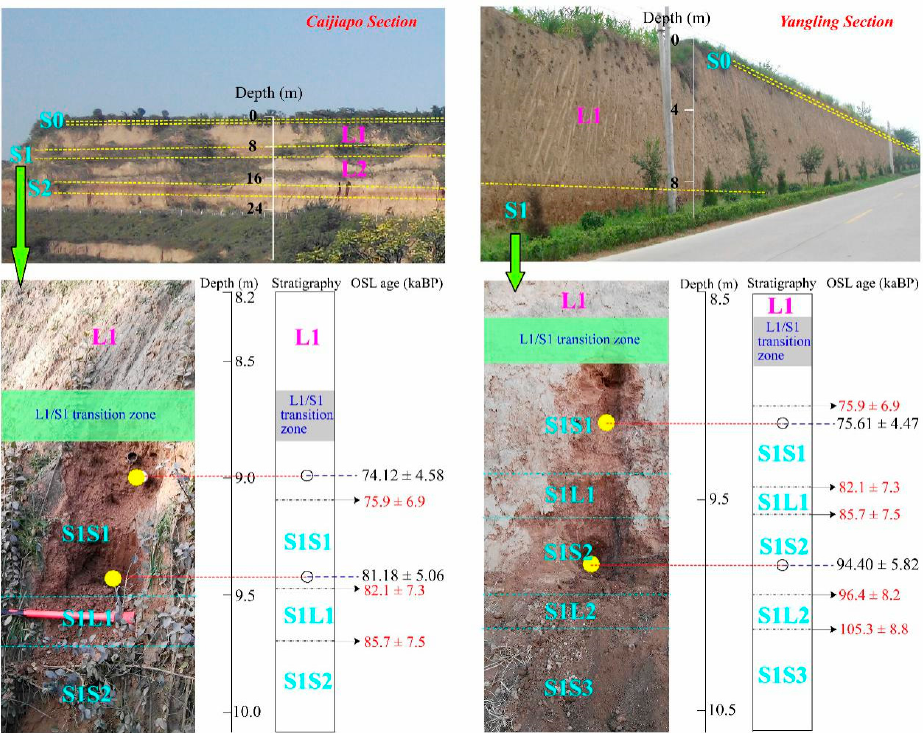
Figure 2. The loess-paleosol sequences at Caijiapo ( left ) and Yangling profiles ( right ). The Caijiapo section showed Holocene loess (S0), last glacial loess (L1), last interglacial paleosol (S1), penultimate glacial loess (L2), and the penultimate interglacial paleosol (S2). The Yangling section showed Holocene loess (S0), last glacial loess (L1), the last interglacial paleosol (S1). The first layer of the paleosols (S1) is divided into five sub-units: three paleosol layers (S1S1, S1S2, and S1S3) and two inter-bedded loess layers (S1L1 and S1L2) [11]. The dashed yellow lines in the upper two photos indicate the exposed paleosol layers. The optically stimulated luminescence (OSL) dating results are provided at the right of each profile photo. The OSL data, in larger font size and in black, were tested in the Laboratory of Neotectonics and Geochronology for the study profiles; the OSL data in red denote the age of S1 in the Weinan profile [28]. The thickness of sub-layers in the CJP and YL profiles are a little different from that in the Weinan profile.